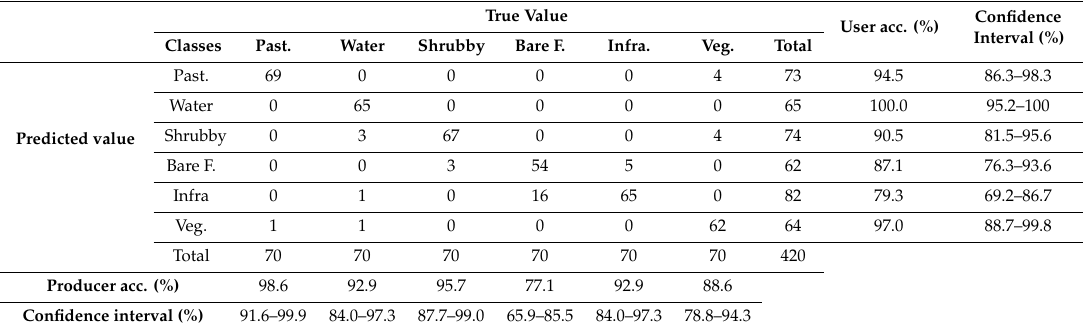
Table 2. Confusion matrix of maximum likelihood classification for the Sentinel-2 image #3.